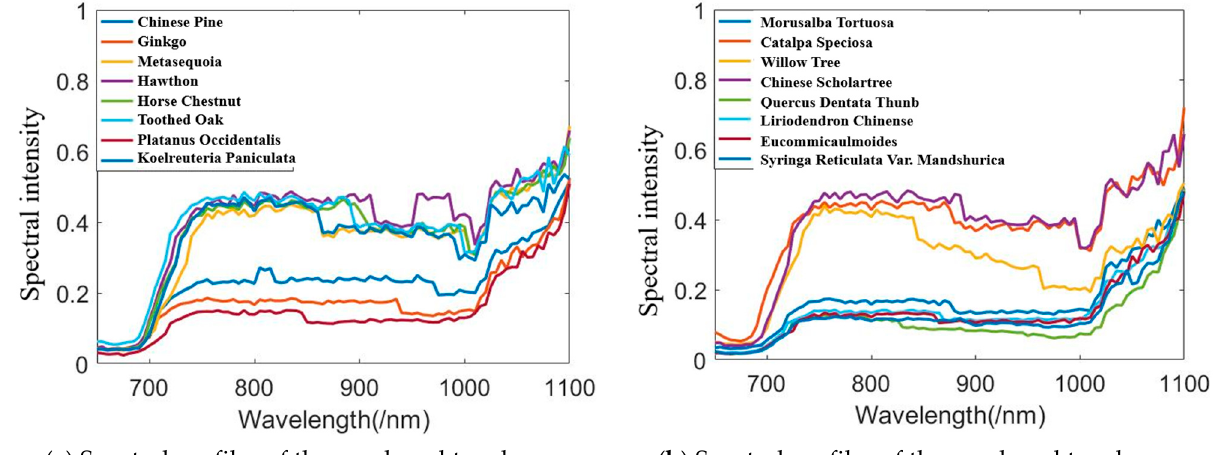
Figure 11. Spectral profiles of the leaves. Table 5. Vegetation spectral indexes results.